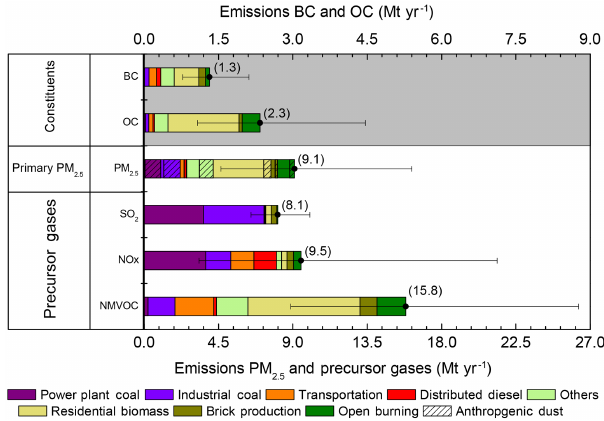
Figure 1. National emissions of particulate matter and precursor gases for 2015 (Mtyr − 1 ). Emissions of NO x are in Mtyr − 1 of NO and emissions of SO 2 are in Mtyr − 1 of SO 2